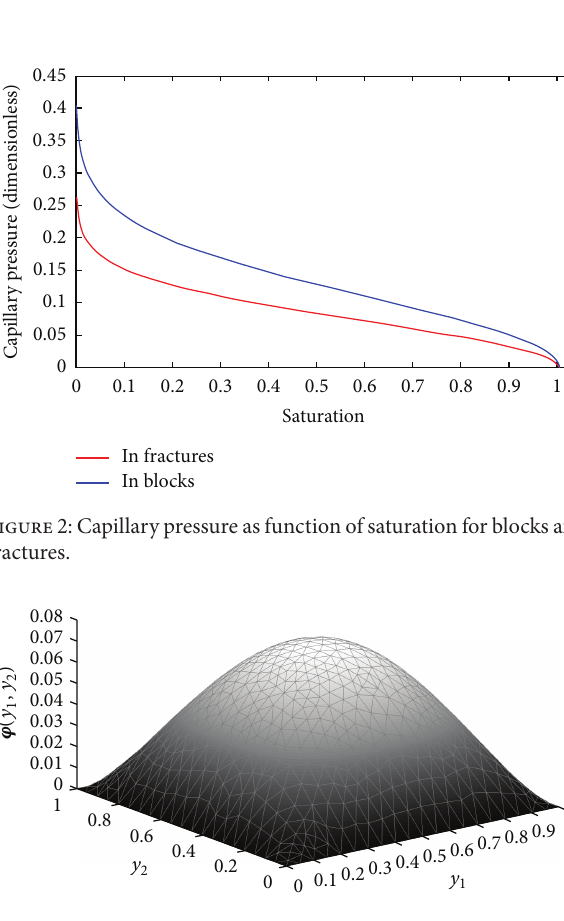
Figure 3: Solution of the cell problem